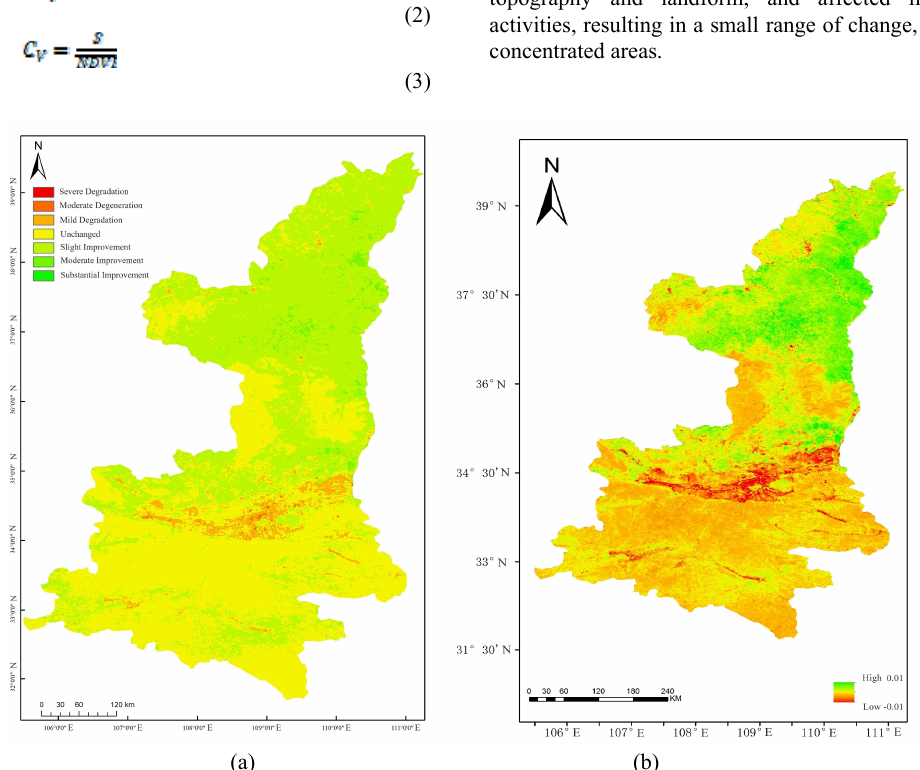
Figure 1. NDVI trend map of Shaanxi Province (a) Slope of NDVI change (b) NDVI trend